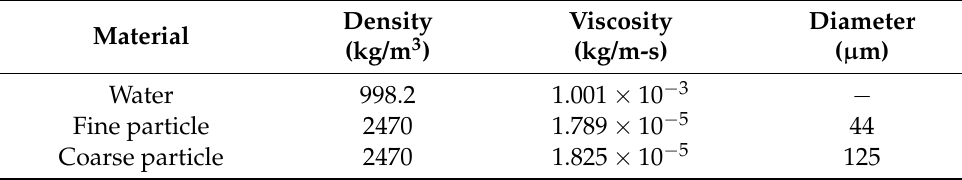
Table 1. Physical properties of water, fine particle and coarse